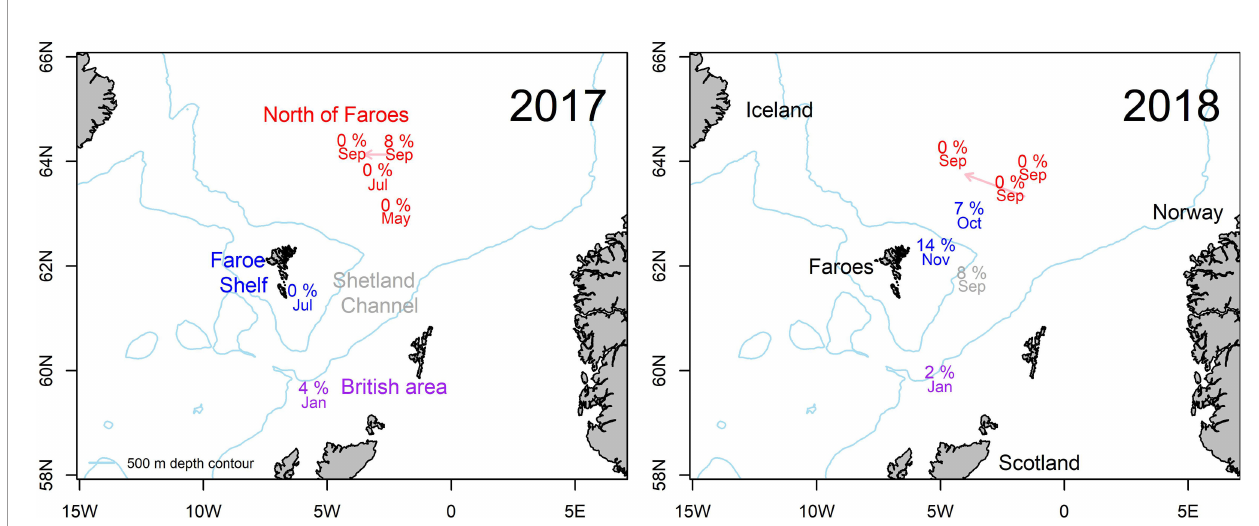
FIGURE 1 | Map of the study area documenting sample locations. Prevalence of Kudoa thyrsites in Atlantic mackerel in 2017 (left) and 2018 (right). Month of capture and prevalence of infection is shown. Arrows indicate displacement of text label for plotting clarity. Text colours correspond to different sampling regions: North of Faroes (Red), Faroe Shelf (Blue), Shetland Channel (grey) and British Area (purple).